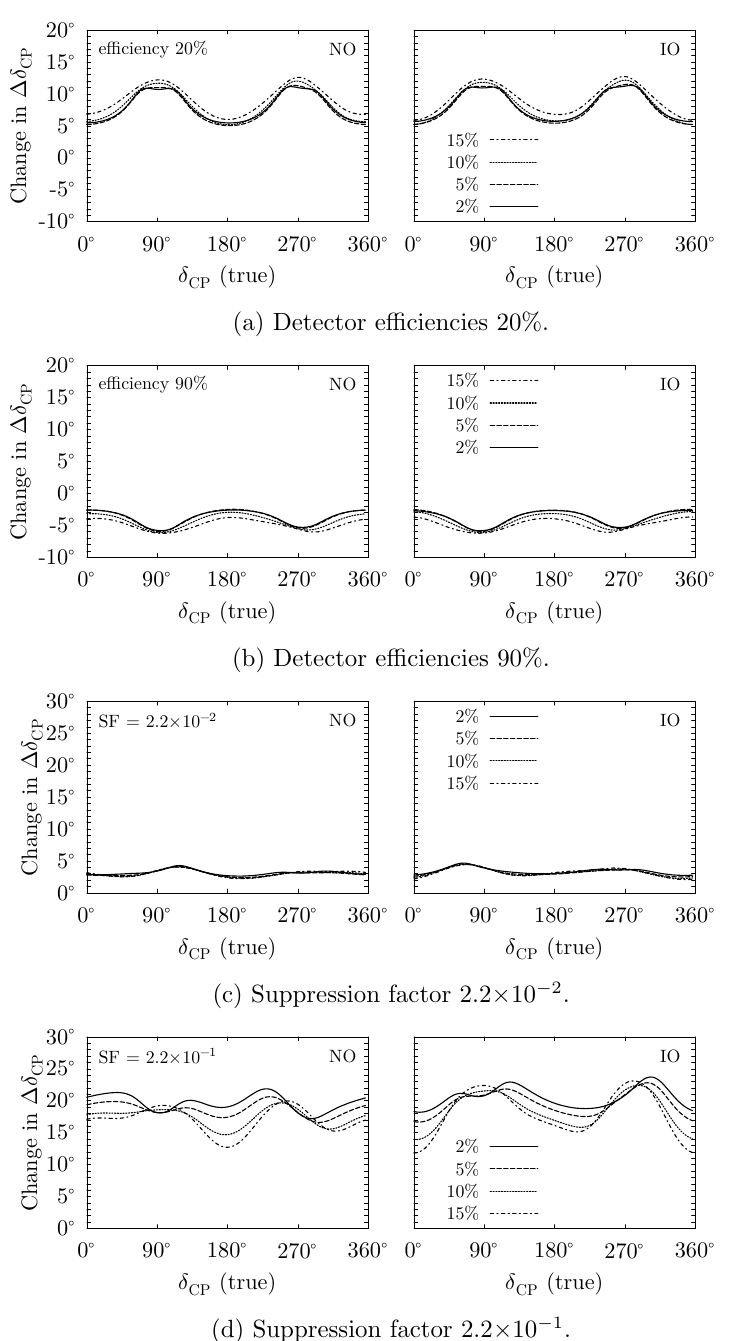
(d) Suppression factor 2.2 (cid:2) 10 (cid:0) 1 . Figure 8. The e(cid:11)ect of detector e(cid:14)ciencies and atmospheric neutrino background on (cid:1) (cid:14) CP in MOMENT when the signal errors are set to 2%, 5%, 10% or 15%. Deviations from the results obtained with the baseline setup are presented for (cid:1) (cid:14) CP when detector e(cid:14)ciencies are set to (a) 20% or (b) 90%, and when the atmospheric neutrino background is suppressed by a factor of (c) 2.2 (cid:2) 10 (cid:0) 2 and (d) 2.2 (cid:2) 10 (cid:0) 2 instead of 2.2 (cid:2) 10 (cid:0) 3 , respectively. The atmospheric neutrino background is calculated with eq. (3.1). The results are shown for both normal ordering (NO) and inverted ordering